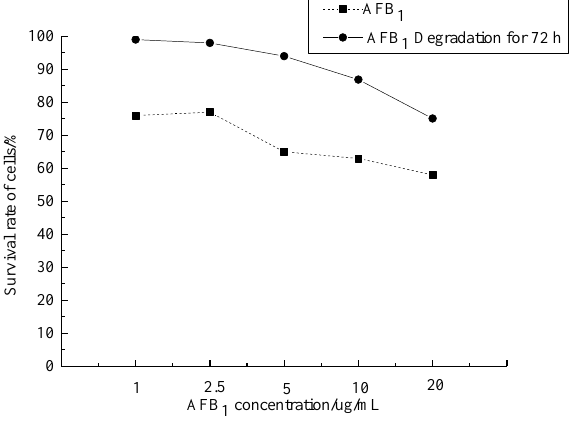
Figure 7. Effect of AFB 1 and its degradation products on HepG2 viability.